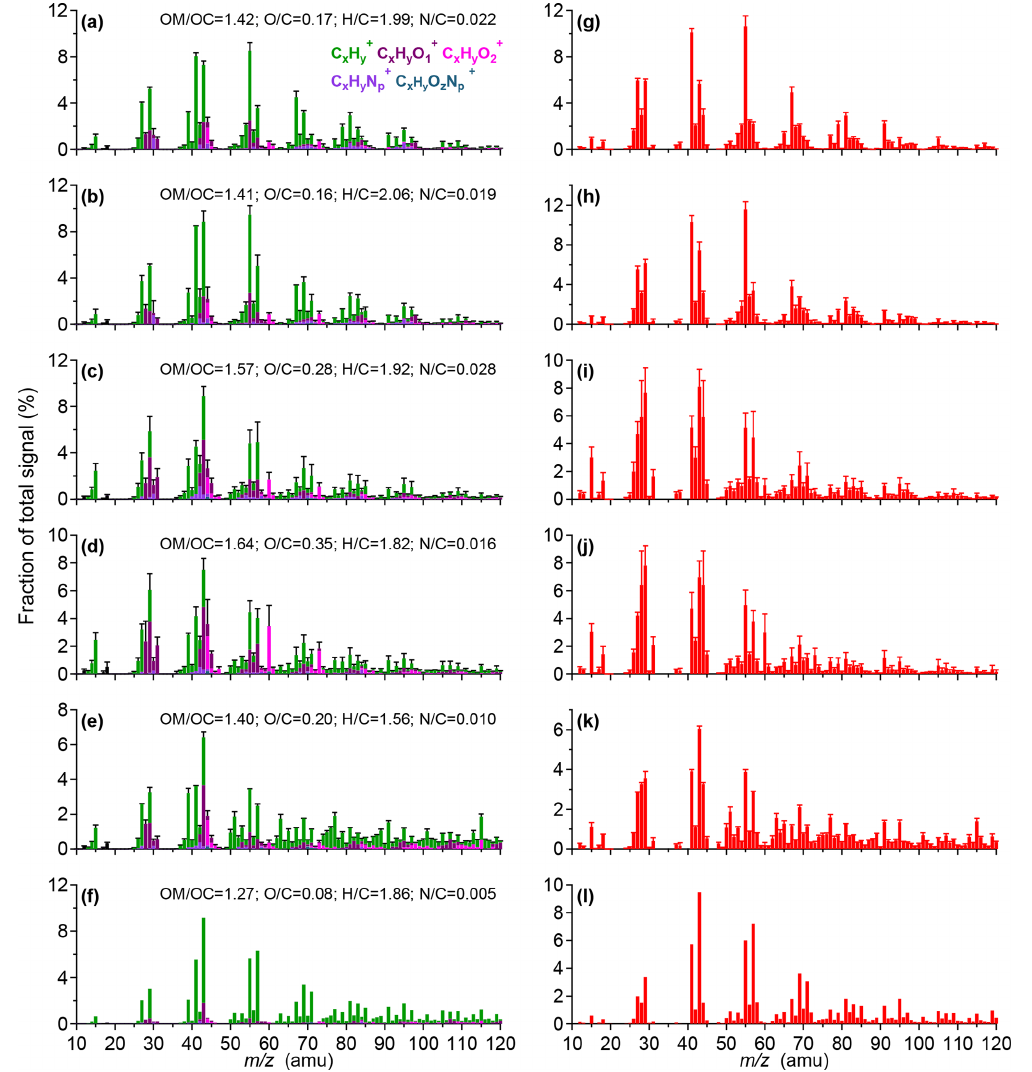
Figure 3. Average mass spectral profiles of OA measured by (a–f) SV-AMS and (g–l) CV-ACSM including (a, g) cooking emissions from vegetable oil, (b, h) from animal oil, (c, i) from crop straw burning, (d, j) from wood burning, and (e) , (k) and (f) , (l) from smoldering and flaming combustion of bituminous coal, respectively. The error bars represent 1 standard deviation. The elemental composition of OA and WSOA from SV-AMS is also shown. The detailed mass spectra for each type of cooking and burning are presented in Fig.